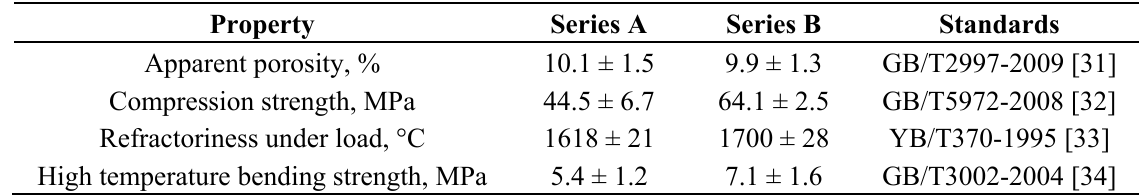
Table 5. The properties of iron ladle bricks with SiC addition and SiAlON